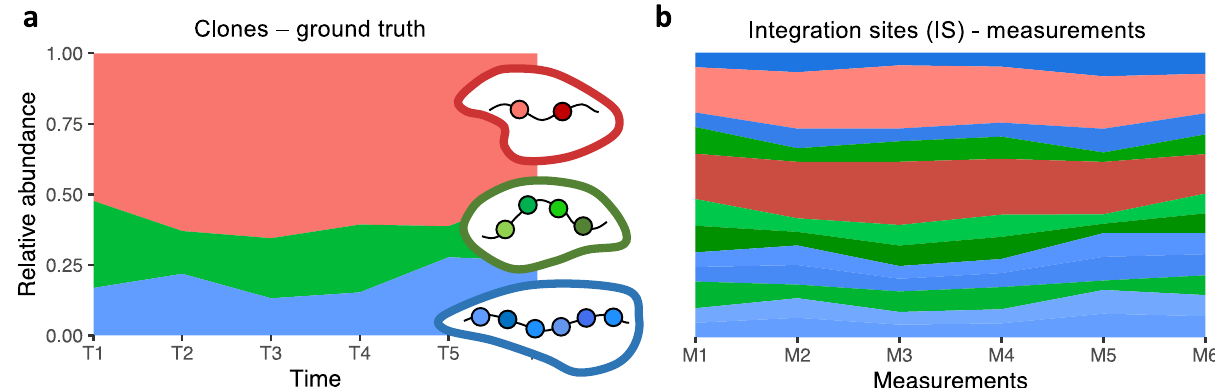
Fig. 1 Sketched example of a clonal time course and the corresponding IS measurements. a Arti fi cial example of a time course depicting the relative abundance of three clones (i.e., clonal ground truth). The insets indicate that each clone is identi fi ed by a variable number of up to six IS. b The corresponding measurement of the IS detects a total of 12 IS. Although the colors indicate the clonal origin, this information is usually not known a priori. Our suggested pipelines aim to use these relative IS abundances to reconstruct the common clonal origin of the different IS and to estimate the true, underlying clonal time course as depicted in a